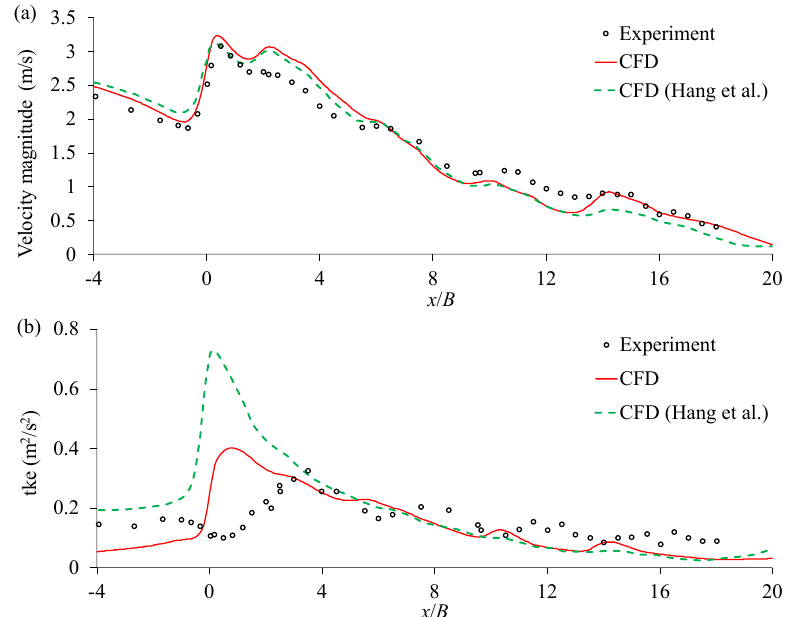
Figure 16. Along-street horizontal profiles of ( a ) velocity magnitude and ( b ) turbulence kinetic energy at elevation z / B = 0.5, where B = 30 mm is the building width. The x -axis is normalized by B , and x / B = 0 corresponds to the first building. Solid lines are from our CFD simulation, both the experimental data and the dashed-lines CFD are from Hang et al.